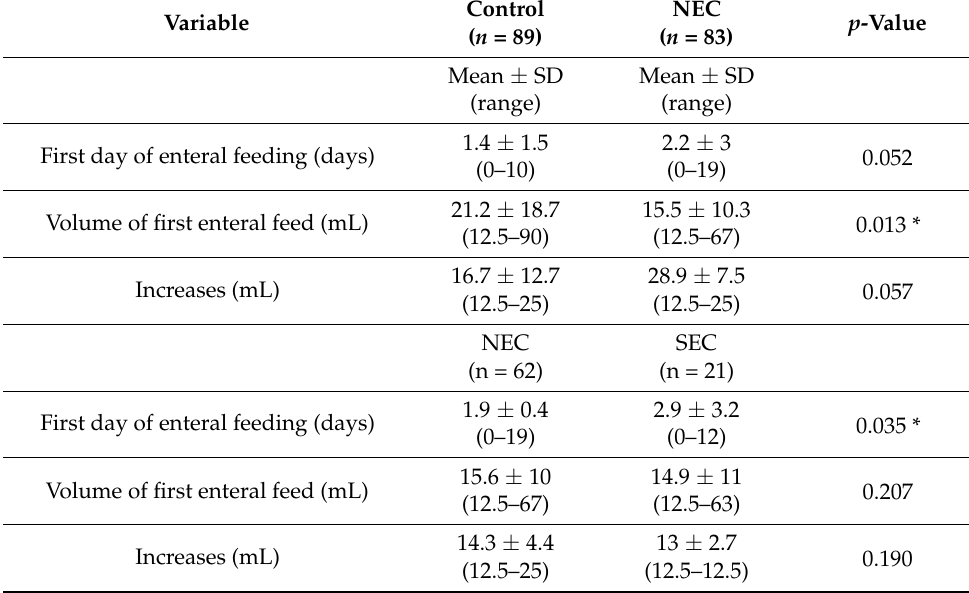
Table 4. First day of enteral feeding and